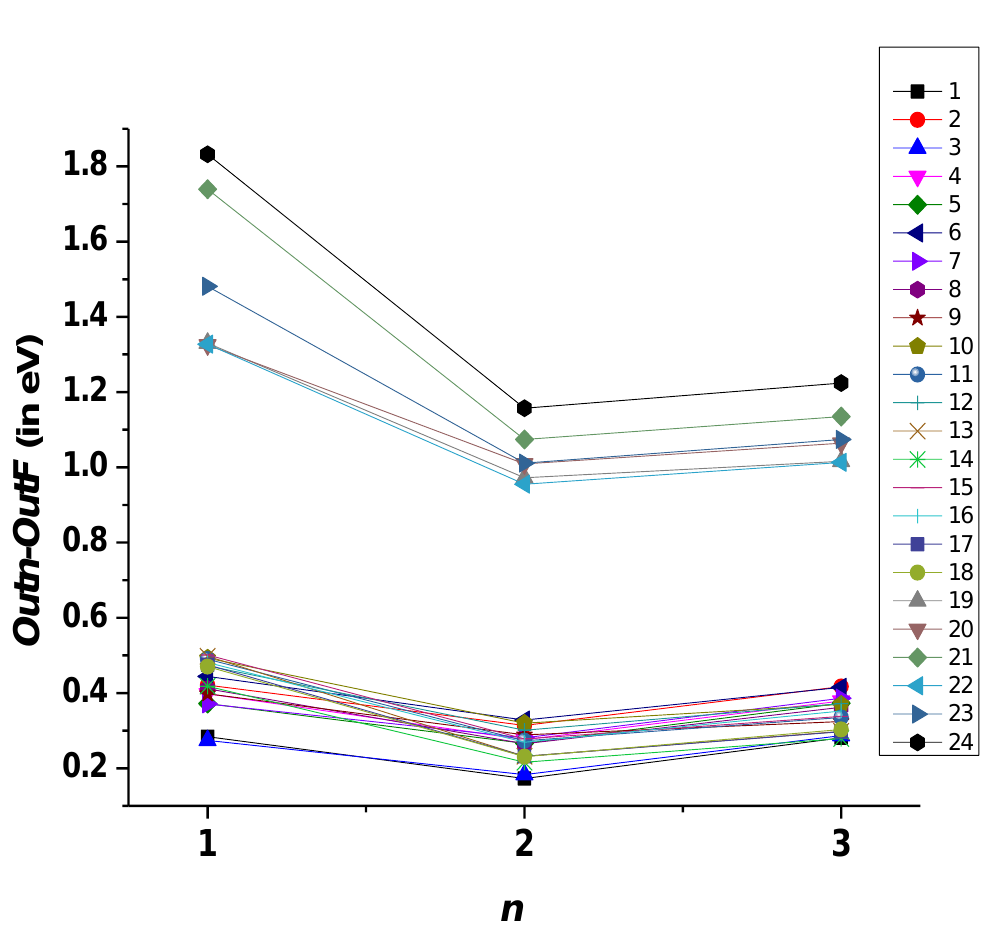
Figure 3. Difference of energy values of each output OUT n ( n = 1, 2, 3) from the final calculation for the 4f 13 5s5p configuration.